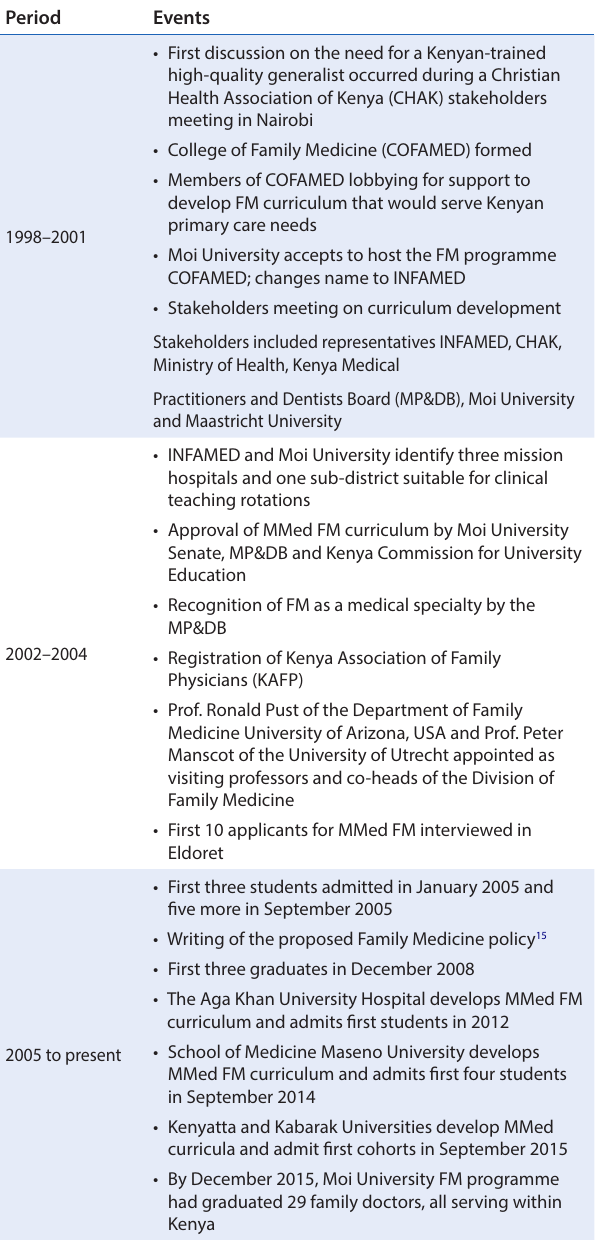
Table 1: Key milestones in the development of FM in Kenya (as narrated by the key informants)